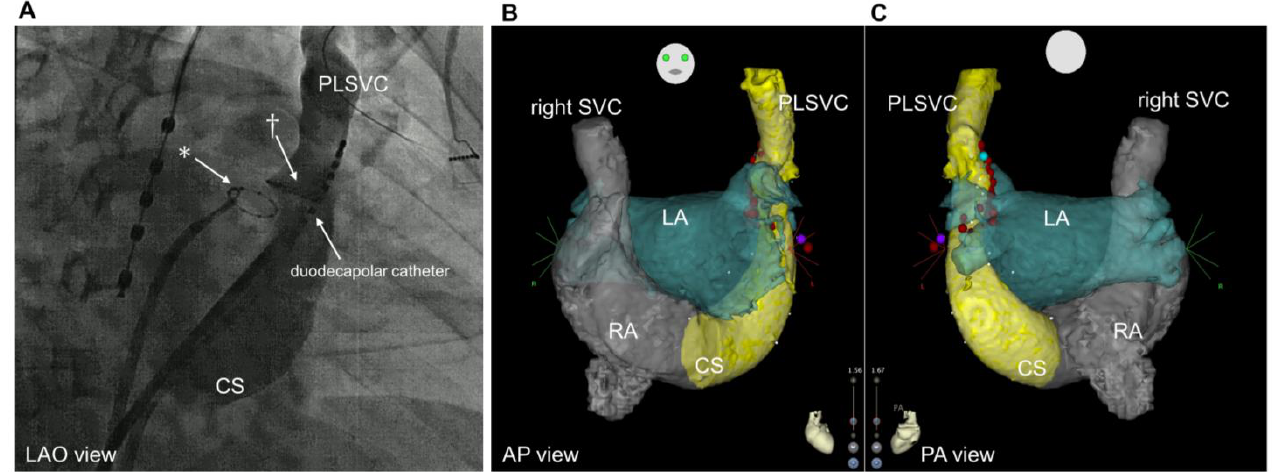
Figure 3. Fluoroscopic images and computed tomography. ( A ): Coronary sinus venography per- formed with a long sheath placed within the dilated coronary sinus (LAO view). * Circular mapping catheter placed in the left inferior pulmonary vein † Circular mapping catheter placed in the PLSVC. ( B ): Preprocedural CT imaging. anteroposterior view. ( C ): Posteroanterior view. CS, coronary sinus; PLSVC, persistent left vena cava; LAO, left anterior oblique; SVC, superior vena cava; LA, left atrium; RA, right atrium; CT, computed tomography.